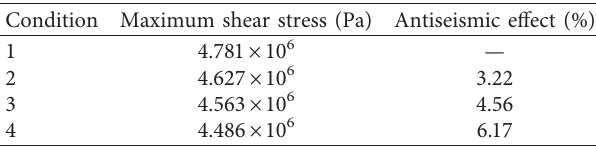
Figure 8: Cloud chart of maximum shear stress of tunnel lining: (a) Condition 1; (b) Condition 2; (c) Condition 3; (d) Condition 4. Table 5: Maximum shear stress and antiseismic